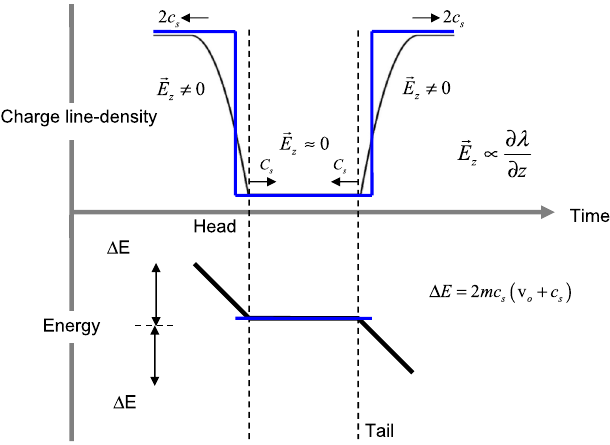
FIG. 1. Beam charge line density and energy profile snapshot illustrations as a function of time, starting from an initially rectangular beam distribution at s ¼ 0 (shown in blue). The curves in black are the same as in blue but at a distance s ¼ s 1 from the